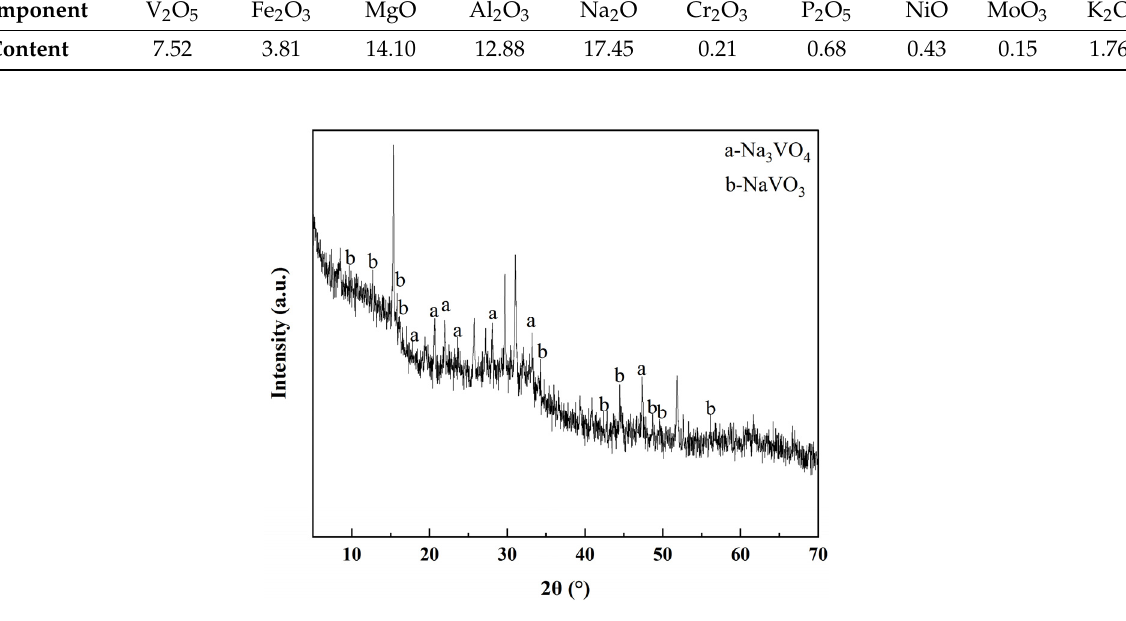
Figure 3. XRD pa tt ern of the precipitate isolated from the acid leaching solution.